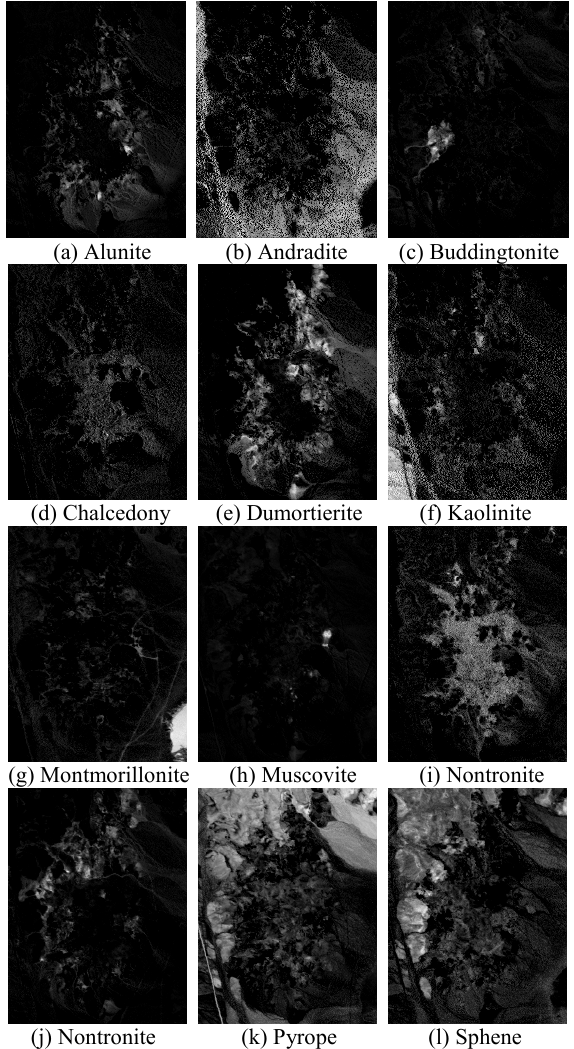
Figure 4. The estimated abundance maps by